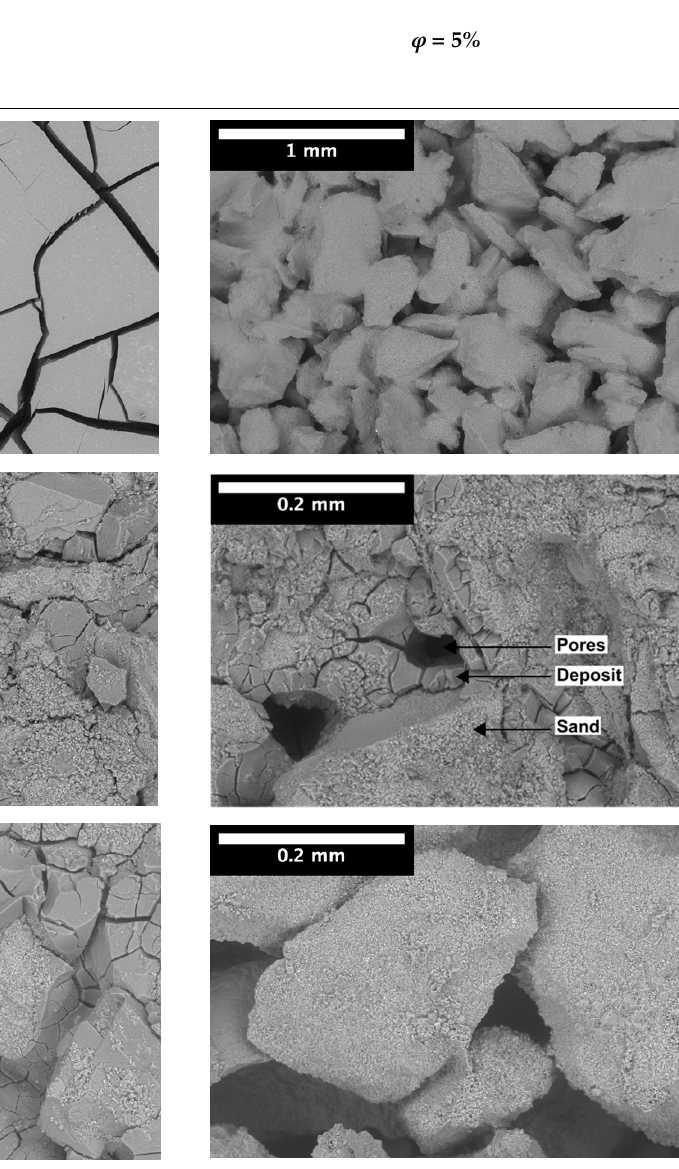
Table 1. SEM image of the dried samples at three depths from the top drying surface. Left: initial particle volume fraction ϕ = 24%; right: initial particle volume fraction ϕ = 5%.